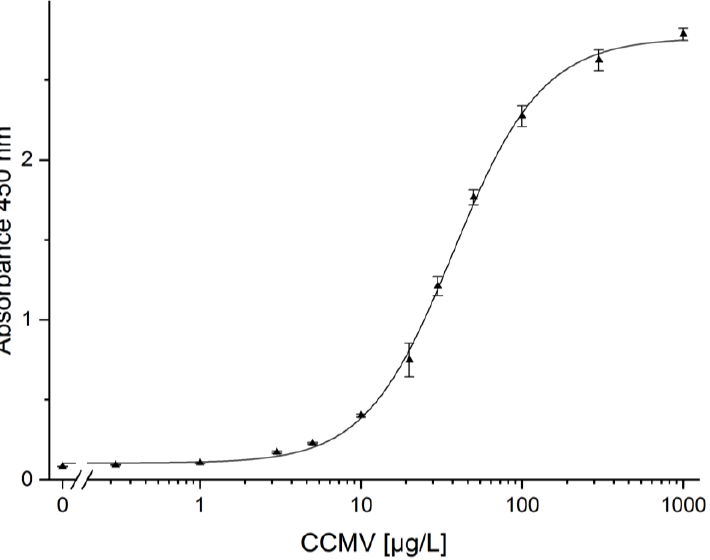
Figure 13. Calibration curve for the determination of CCMV with a sandwich enzyme-linked immunosorbent assay (ELISA). Error bars correspond to the standard deviation of quadruplicates. LOD and LOQ were calculated to be 0.25 µg/L, and 0.79 µg/L, respectively. No matrix effect was